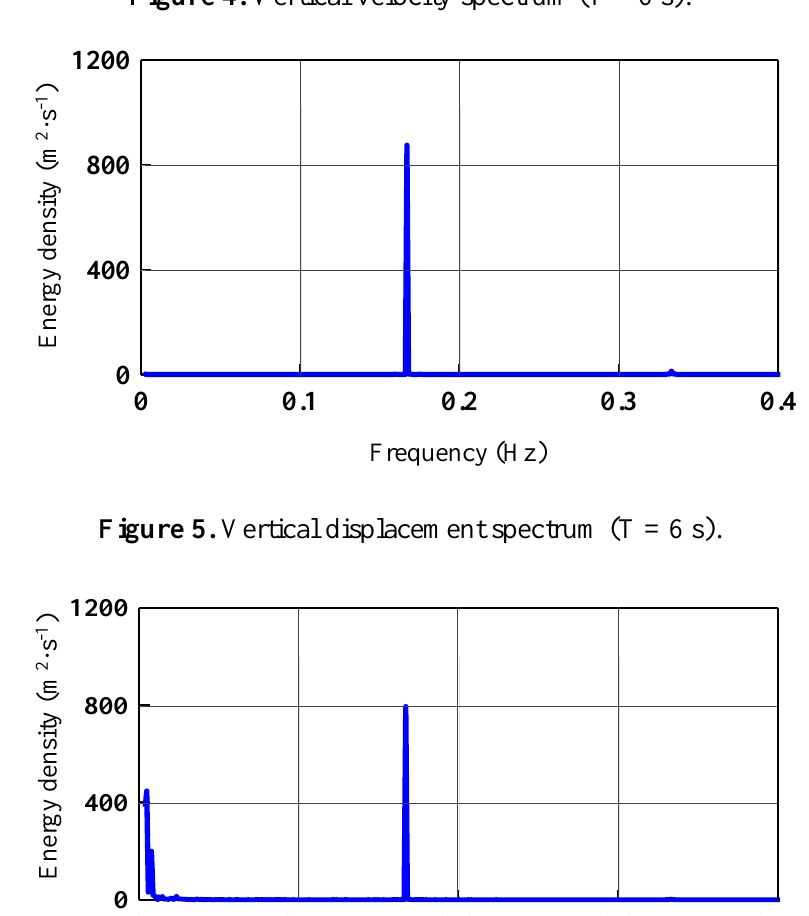
Figure 4. Vertical velocity spectrum (T = 6 s).